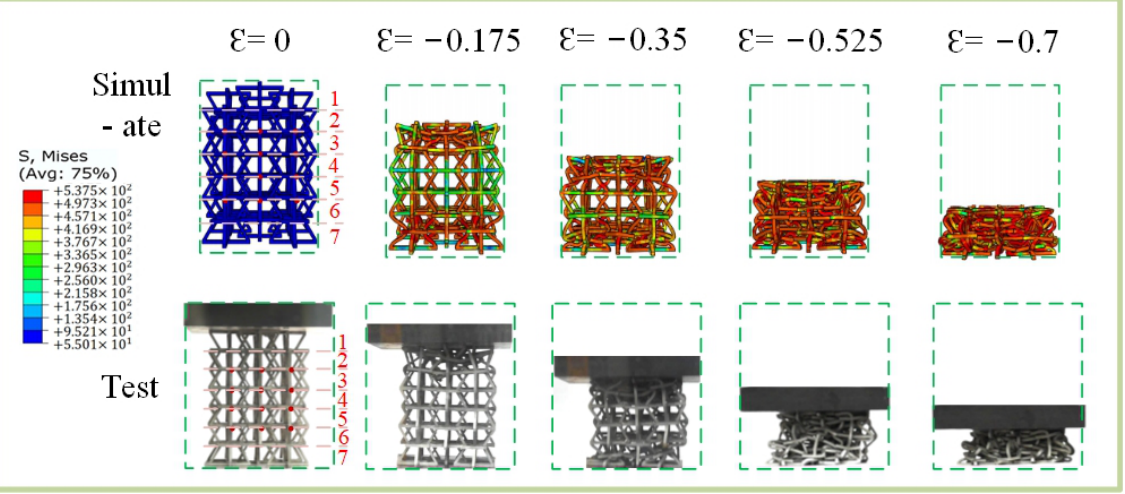
Figure 20. Comparison of simulation experiments in the x direction.